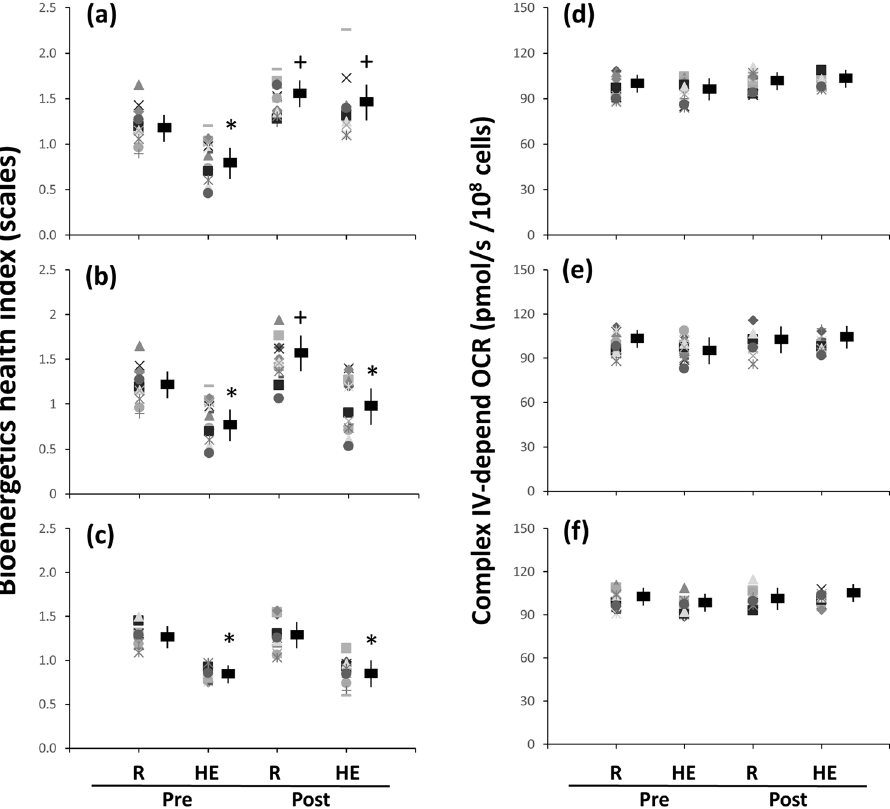
Figure 6. Effects of interval and continuous exercise regimens on (a–c ) bioenergetics health index (BHI) and (d–f) Complex IV activity in platelets. HIT , high-intensity interval training group (a , d) ; MCT , moderate- intensity continuous training (b , e) ; CTL , control group (c , f) ; Pre , pre-intervention; Post , post-intervention; R , resting; HE , hypoxic (12%O 2 ) exercise test. * P < 0.05, R vs. HE ; + P < 0.05, Pre vs. Post . Values were mean ± SEM.